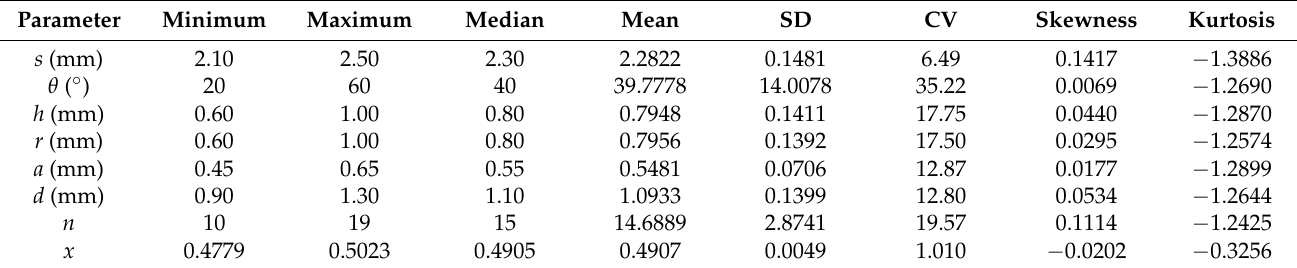
Table 3. Numerical characteristics of the